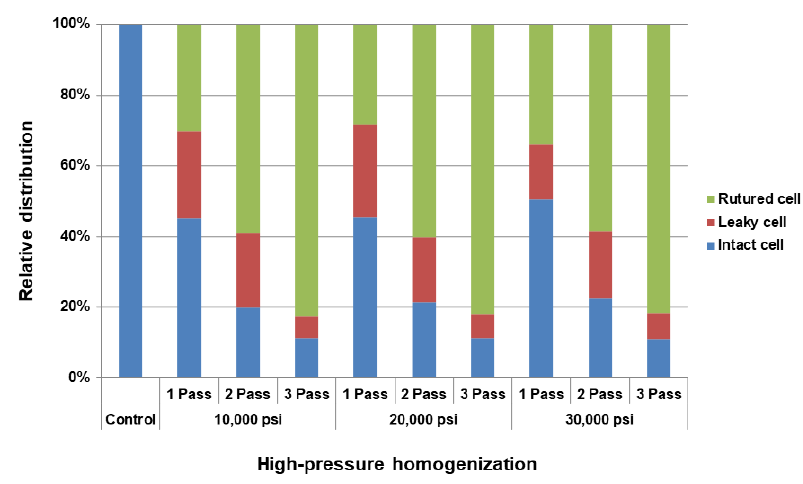
Figure 2. Cell type distribution of H. pluvialis cysts after various high-pressure homogenization treatments (pressure, 10,000–30,000 psi; passage, 1–3). The cell types were classified into intact, leaky, and ruptured according to the morphological features that are based on the microscopic observation (Figure